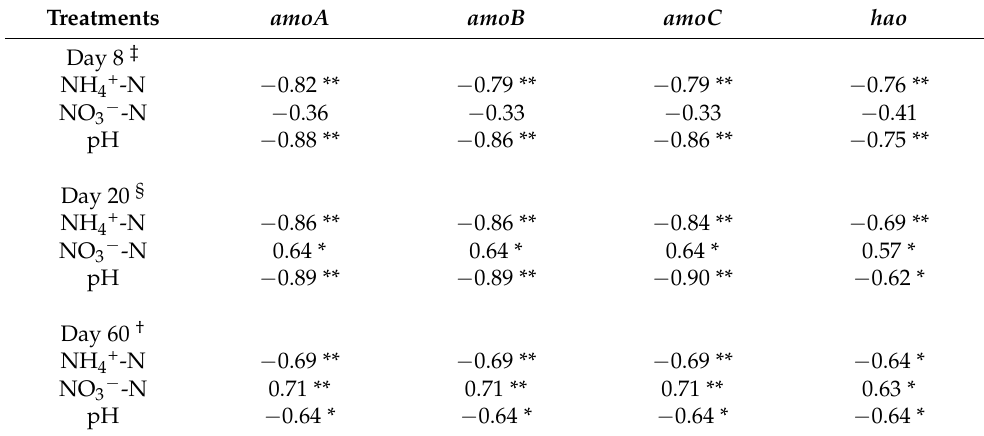
Table 7. The Spearman’s correlations (r) between soil properties and nitrification genes at different incubation times for Dangtu (DT) soil.